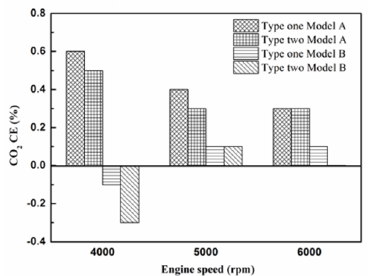
Figure 25. The CO 2 ( a ) emission values and ( b ) CE of control voltage 5 V using iridium alloy.